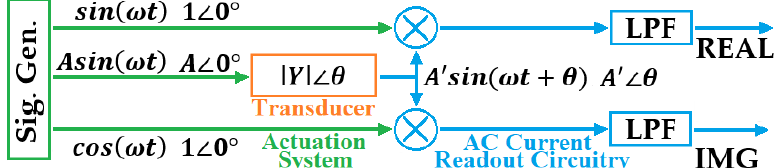
Figure 1. Single channel (Frequency Response Analyzer) FRA-based impedance spectroscopy (IS) system block diagram.